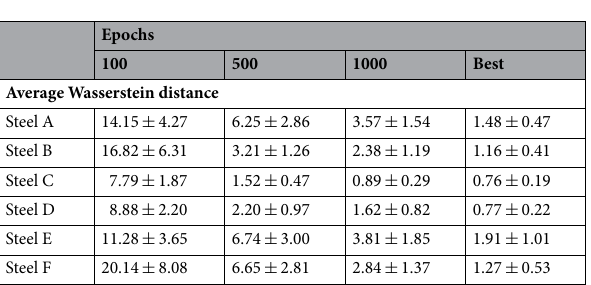
Table 7. Summary of average Wasserstein distances at different